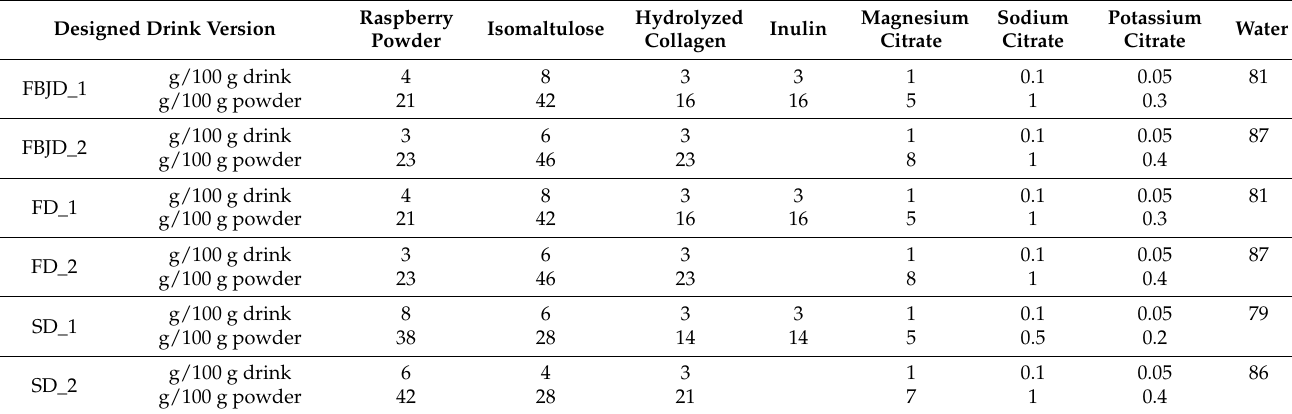
Table 1. Recipe compositions of designed